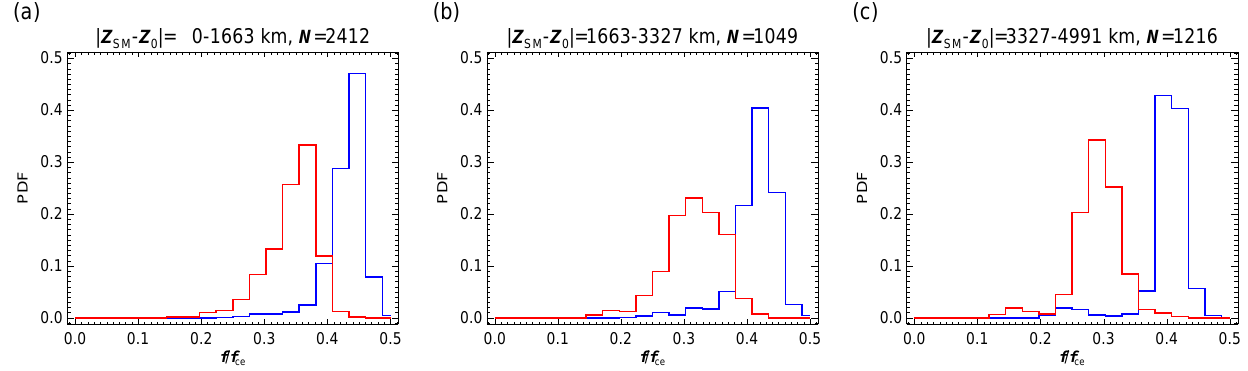
Fig. 9. Estimates of the probability density functions of lower frequencies f 1 (red lines) and upper frequencies f 2 (blue lines) of individual chorus wave packets. The three panels (a) , (b) , and (c) show, respectively, the results for three different intervals of distances Z S M − Z 0 from the central position of the source